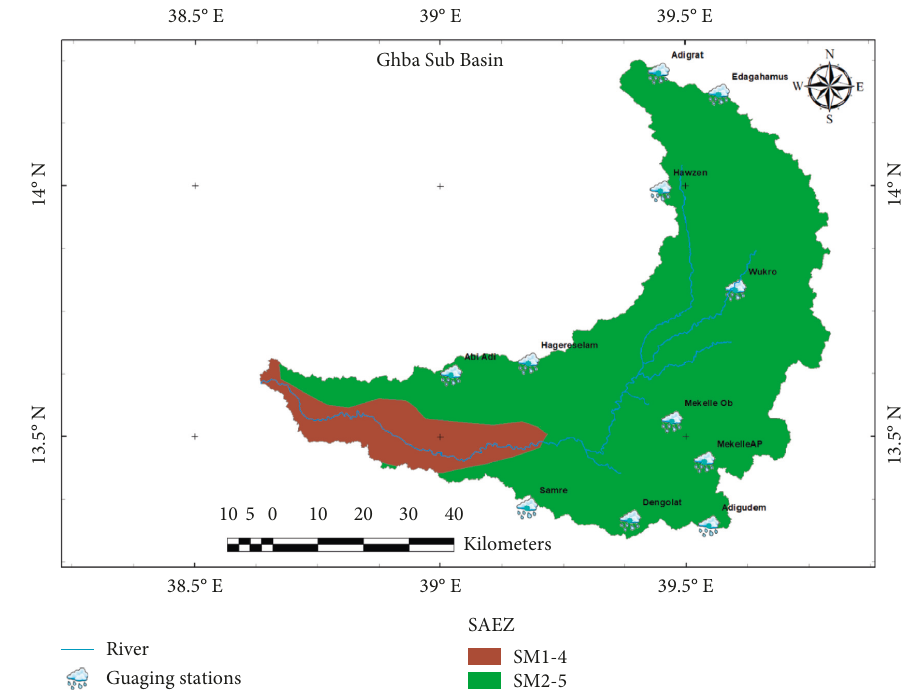
Figure 1: Agroecology and meteorology stations of the Ghba subbasin.